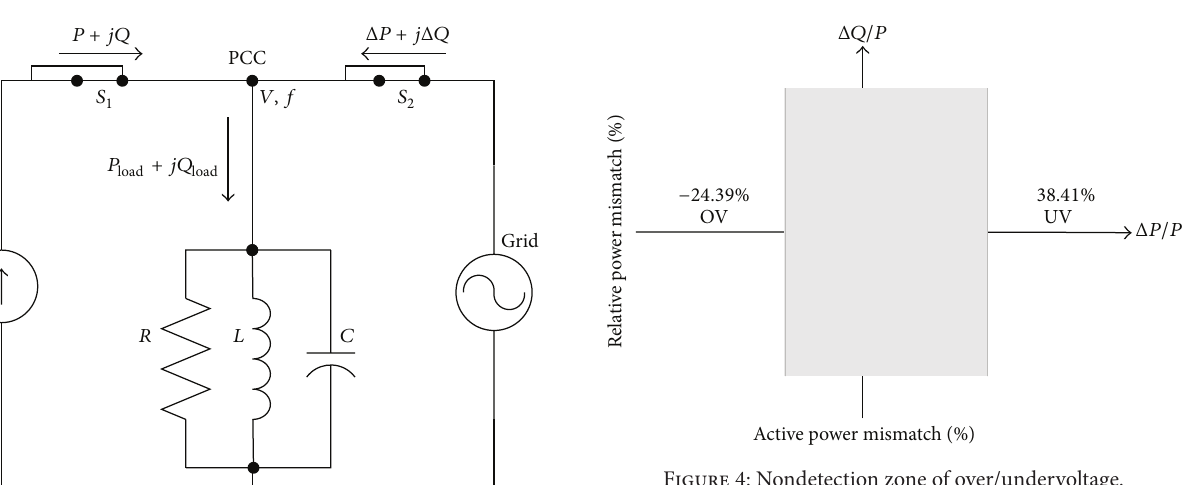
Figure 4: Nondetection zone of